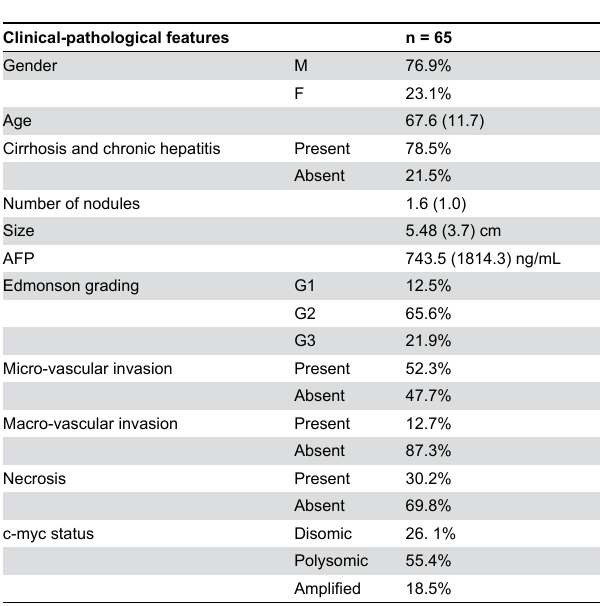
Table 1. Clinical and pathological characteristics of 65 patients affected by HCC.